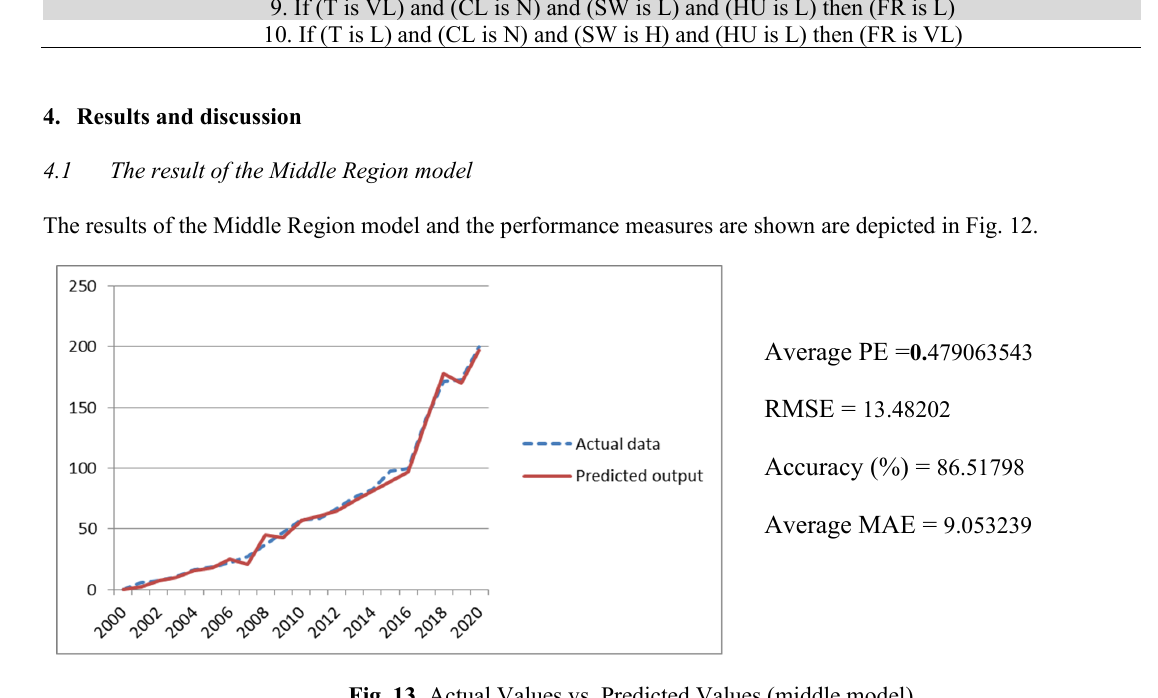
Fig. 11. Membership functions related to rainfall (FR) – middle model Sample of fuzzy rules for the middle region model